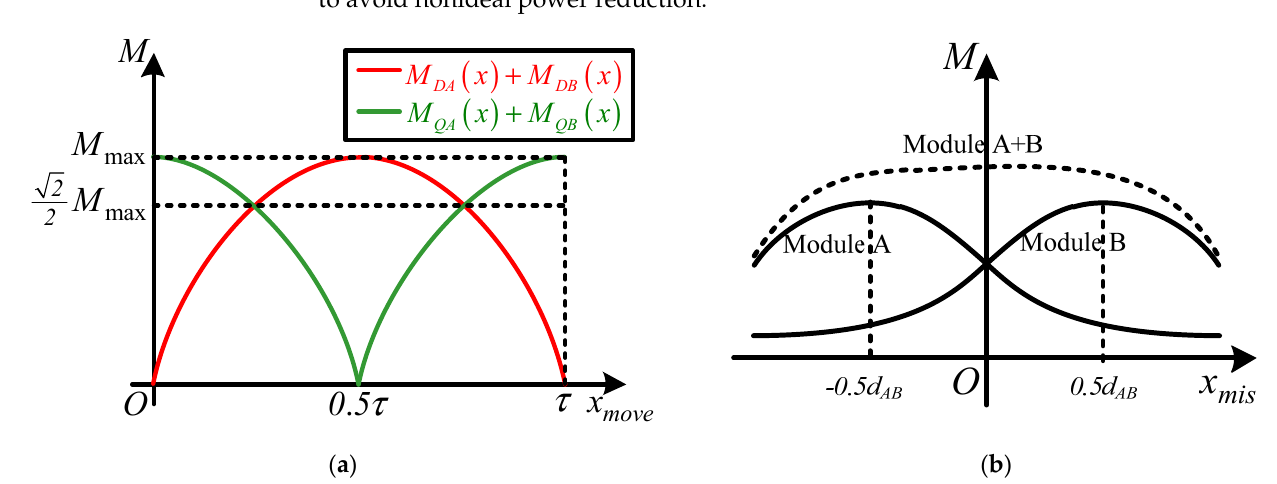
Figure 3. The characteristic of mutual inductance of the dual-phase NSP receiver with ( a ) moving distance and ( b ) misa- lignment distance.